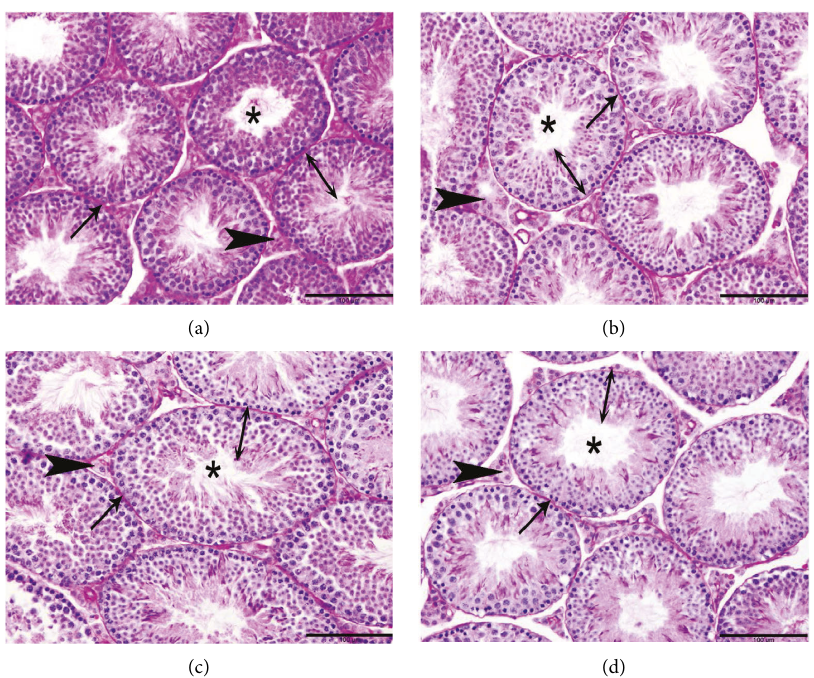
Figure 5: Photomicrograph of mice’s testis (Bar � 100 μ m; Stain: HPAS); (A–D) groups 1–4, showing normal histological structures of the seminiferous tubule, with a complete spermatogenesis process (double arrow), mature Sertoli cells (arrows), intact Leydig cells (arrow- heads), and an appropriate percentage of mature spermatozoa (asterisks) (corresponds to grade I Cosentino grading classifications). (a) control; (b) lyophilized extract; (c) nonpolar fraction extract; and (d) polar fraction